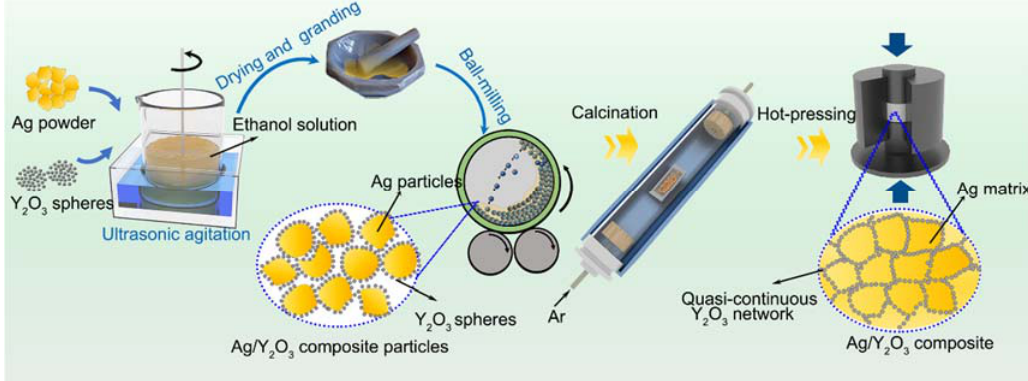
Figure 1. Schematic diagram of the preparation of Ag/Y 2 O 3 sintered compact.